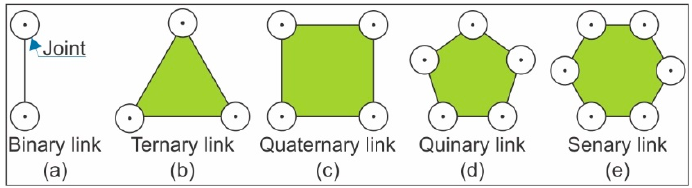
Figure 4. Types of links.